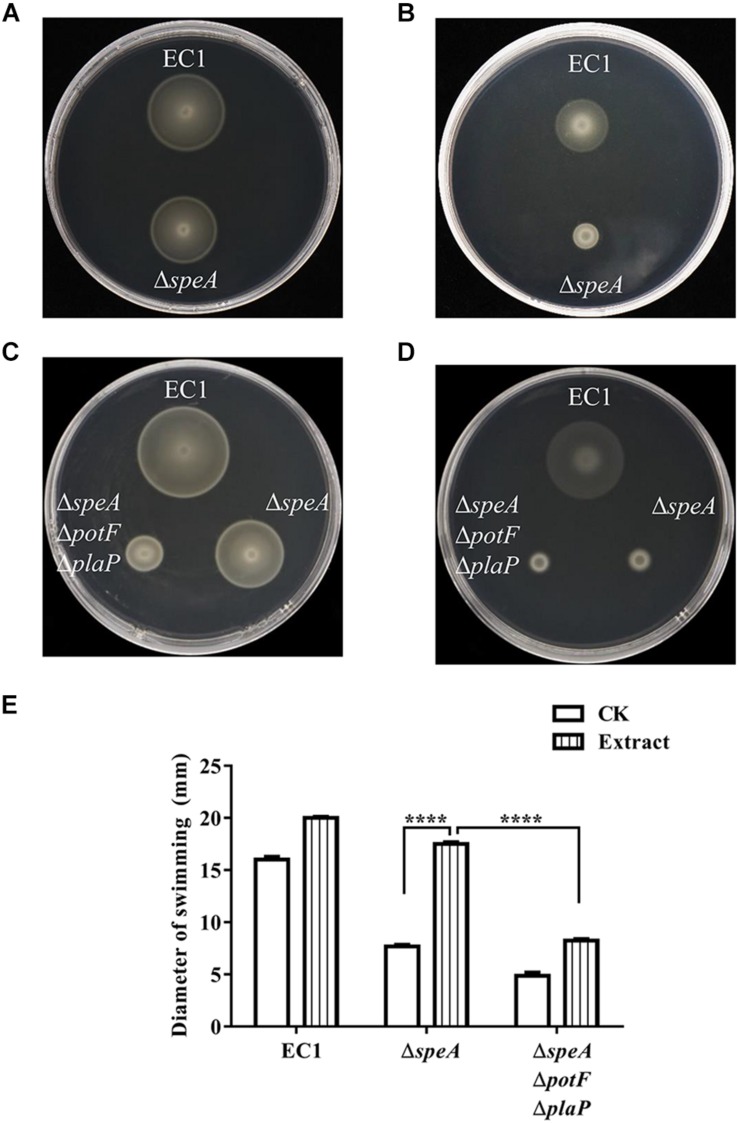
Effect of host cell extract on bacterial swimming motility. The swimming motility of the D. zeae strain EC1 and the speA-disrupted mutant ΔspeA in the presence of rice extract (A), and water (B). The swimming motility of strain EC1, mutants ΔspeA and ΔspeAΔpotFΔplaP in the presence of rice extract (C) and water (D). (E) Quantitative determination of bacterial cell swimming motility of strain EC1 and its derivatives in the presence of rice extract and water (CK). The data shown are the means ± SE (n = 3). ****P < 0.0001.